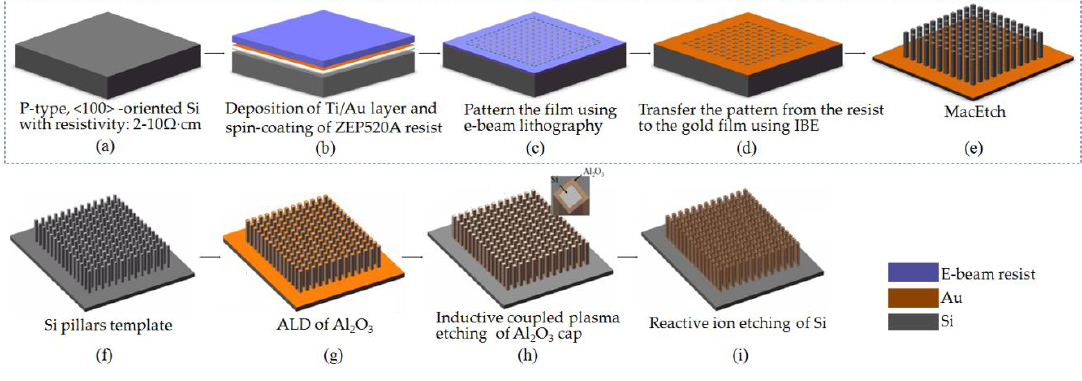
Figure 1. Schematic diagram of the sidewall transfer MacEtch process for the realization of the Al 2 O 3 nanotube arrays with ultra-high aspect ratios: ( a ) silicon substrate; ( b ) deposition of the Ti / Au layer and ZEP520A resist; ( c ) electron beam lithography; ( d ) ion beam etching; ( e ) metal assisted chemical etching (MacEtch); ( f ) Si pillars template; ( g ) atomic layer deposition (ALD) Al 2 O 3 film; ( h ) dry etching; ( i ) reactive ion etching of Si.